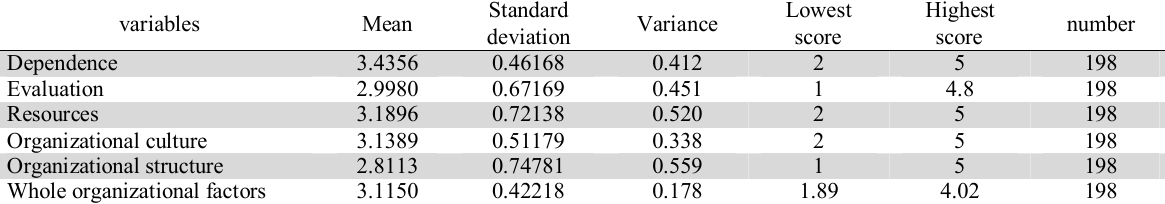
Descriptive statistics of data in terms of organizational factors